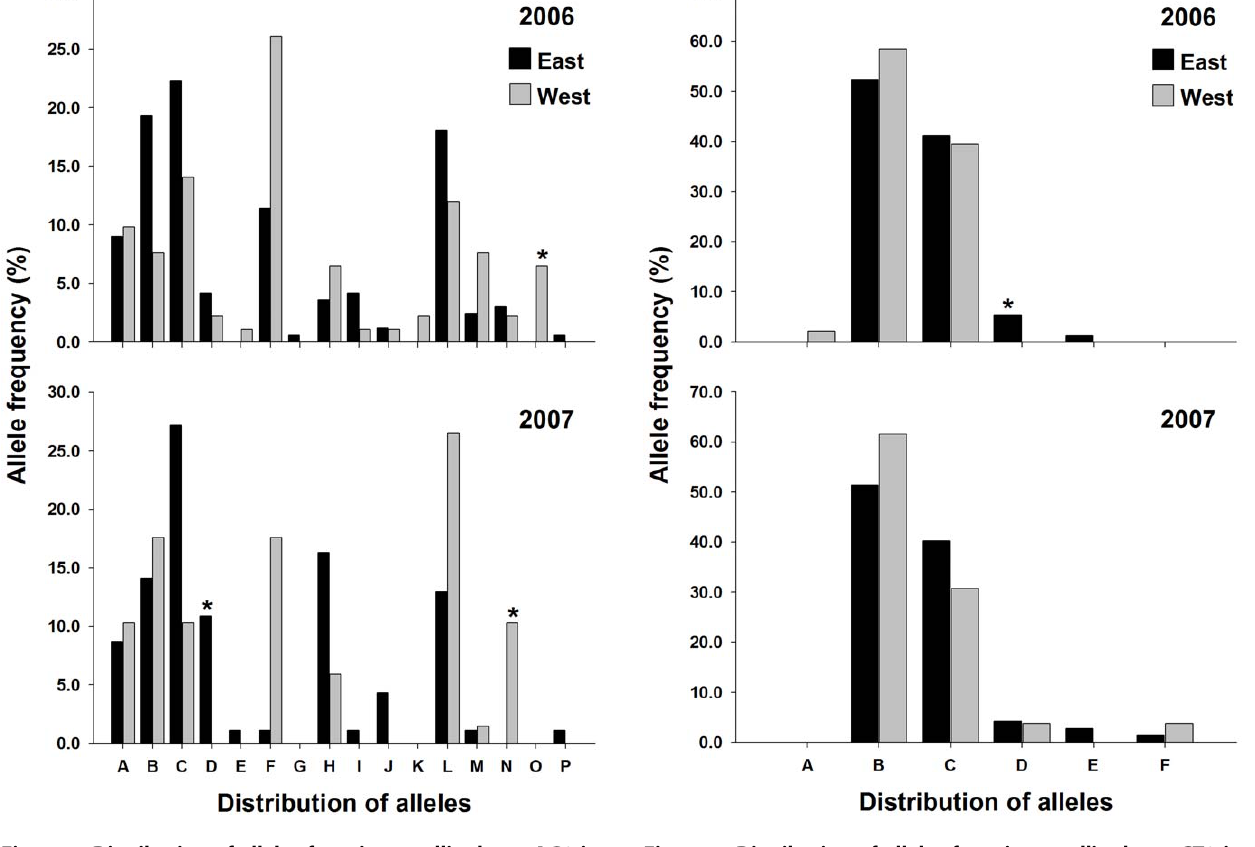
Figure 4. Distribution of alleles for microsatellite locus AG2 in 2006 and 2007. *Denotes private alleles with a frequency of . 5%.